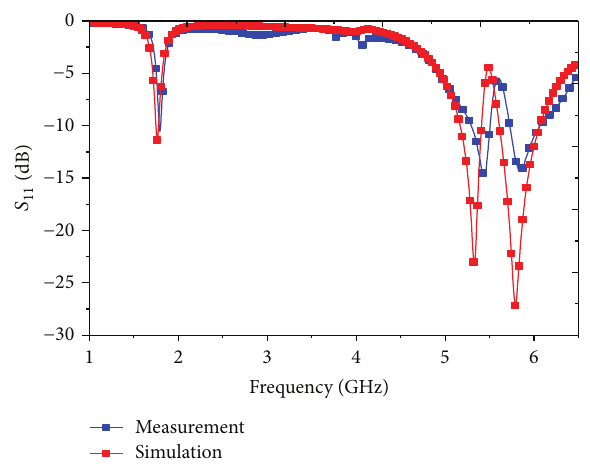
Figure 7: Simulated and measured |𝑆 11 | of the proposed antenna.